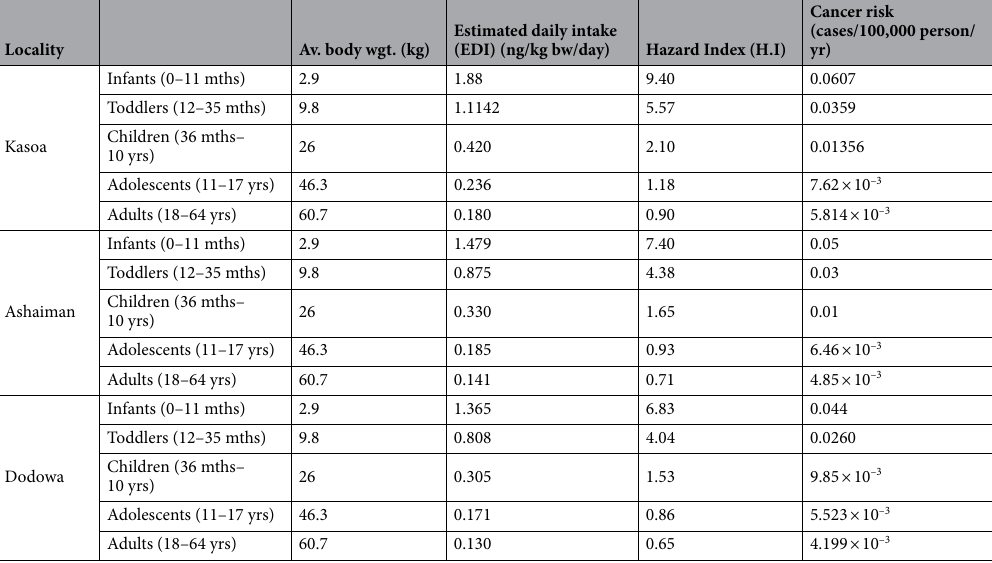
Table 5. Risk evaluation for AFM 1 via consumption of brukina samples obtained from Greater Accra region of Ghana. Means of aflatoxins M1—Kasoa—0.79 µg/kg, Ashaiman—0.62 µg/kg, Dodowa—0.5780 µg/kg. Daily intake of milk for infants was halved (0.5 × 0.0137 kg). Average Body weights were obtained from the different ranges referenced by the authors. Average potency for AFM 1 = 0.0323. 1 µg = 1000 ng. H.I Hazard